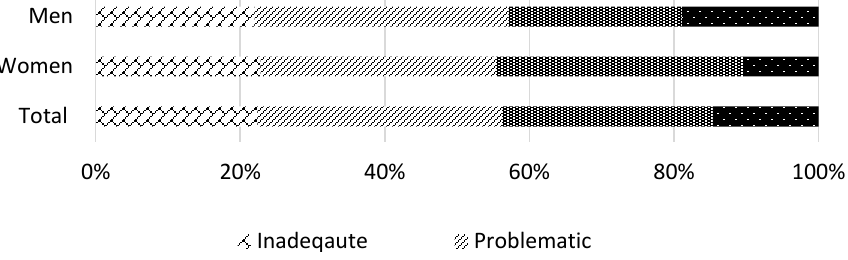
Figure 1. Level of health literacy by sex.